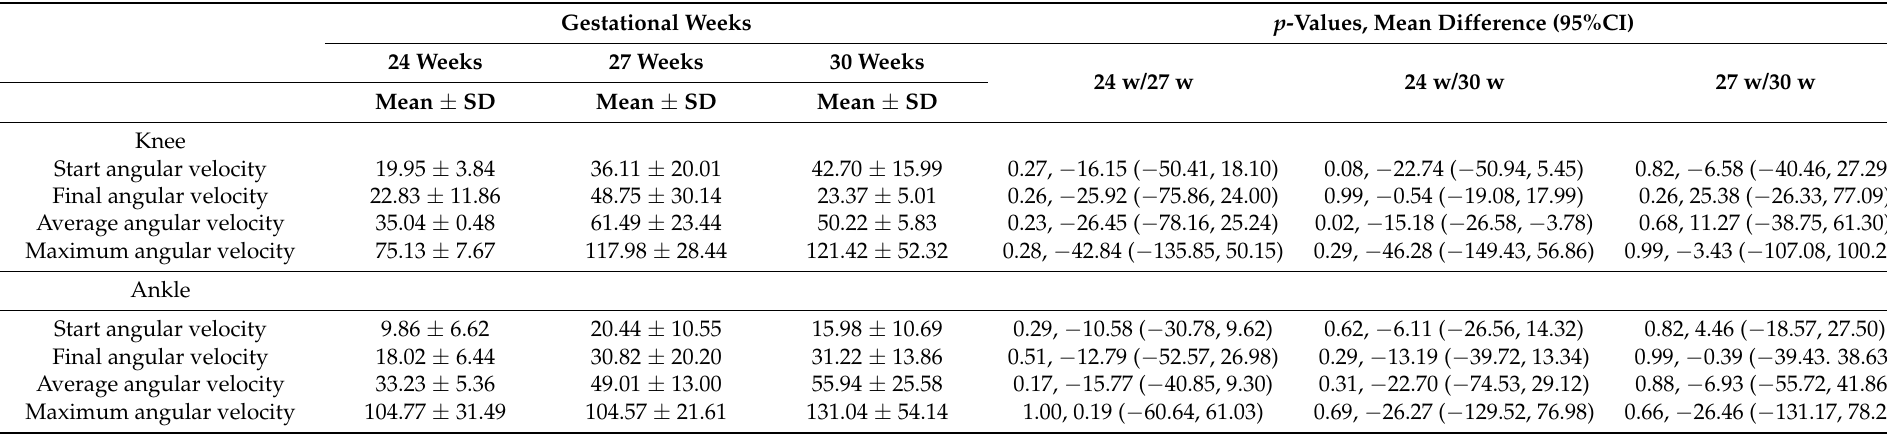
Table 2. Lower limb joint angular velocity changes during kicking motion at 24, 27, and 30 gestational weeks (angular velocity: